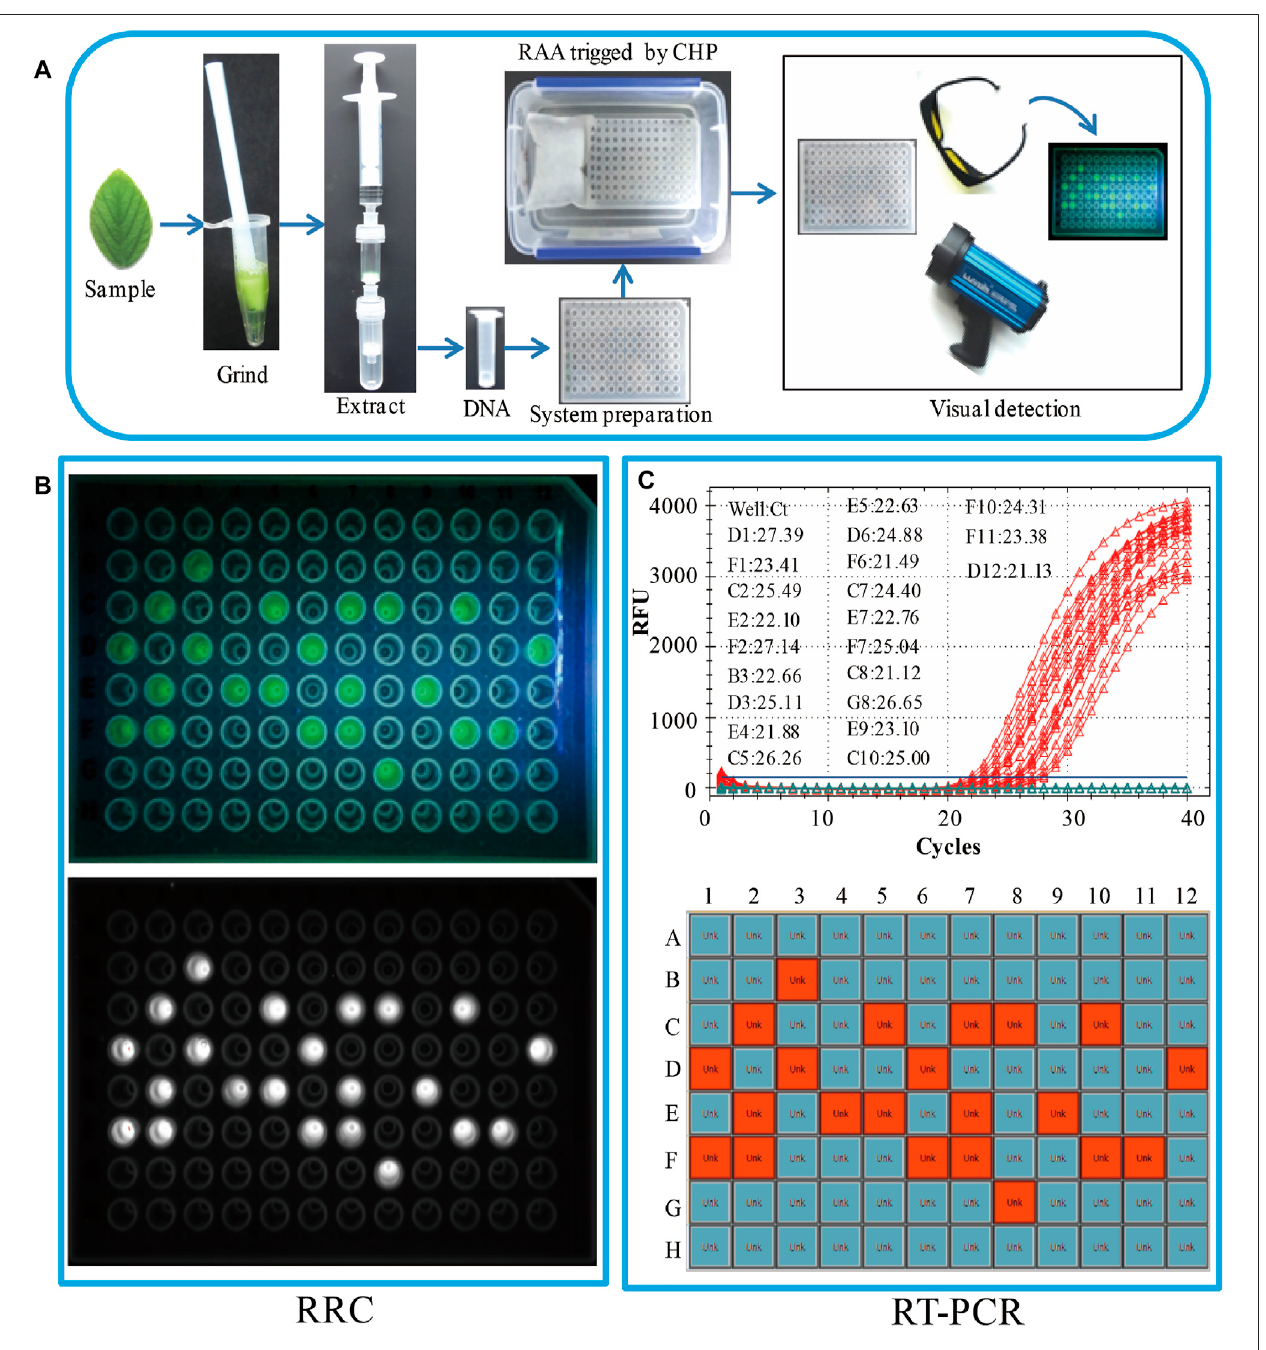
FIGURE3| Realsampleon-sitedetectionbytheRRCplatform. (A) Thework fl owoftheRRCplatformforon-sitedetection. (B) Thevisual fl uorescenceresultofthe RRC platform. The visual detection result under blue light (top panel) . The visual detection result of a fl uorescence imaging system (bottom panel) . (C) The detection results of RT-PCR. The ampli fi cation curve and Ct value (top panel) . The position of positive sample in the 96-well plate (bottom panel) .